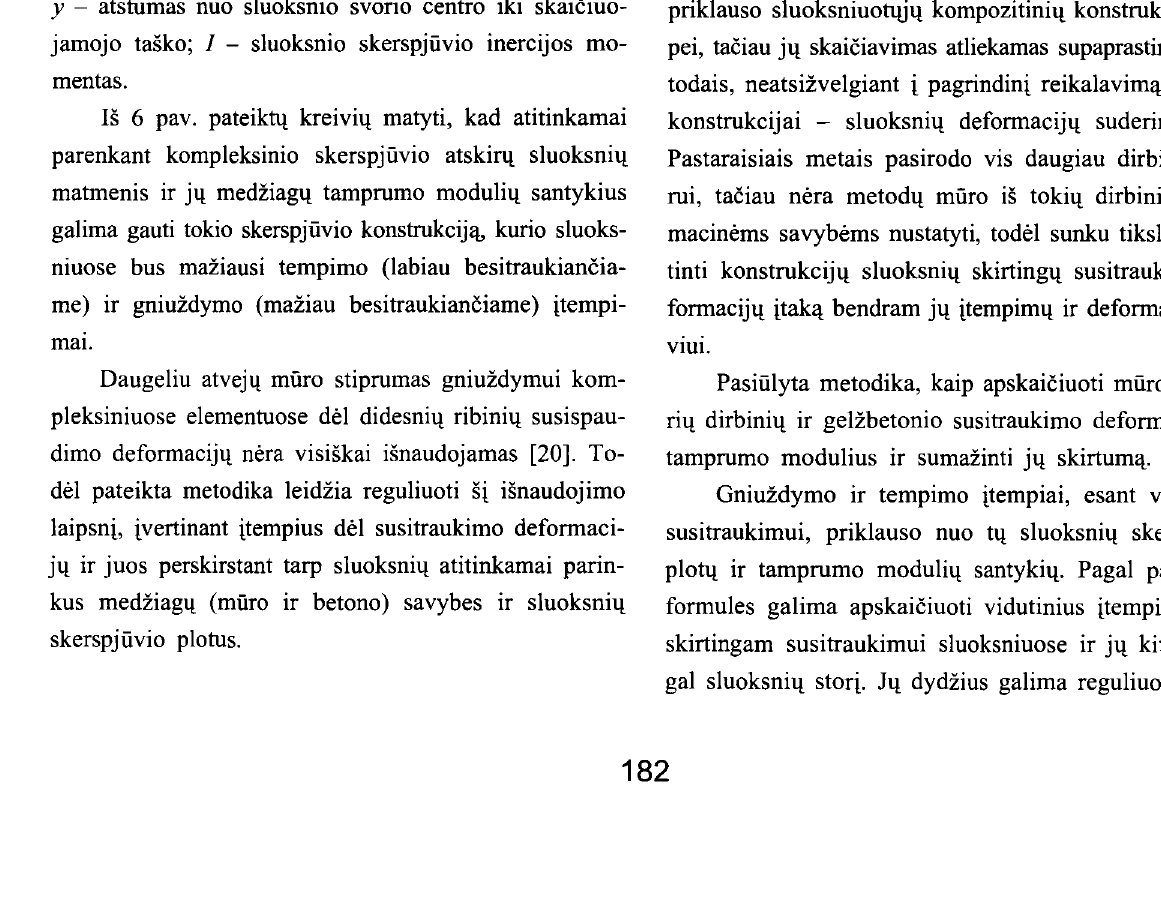
skerspjiiviq plotq (AJ! A 2 ) santykiq ir medziagq tamprumo moduliq (EI (t)j E2 (t)) santykiq: - gniuzdymo itempiai; - - - tempimo itempiai (skaiciai prie kreiviq reiSkia (EI (t)/ E2 (t)) santykiq dydi Fig 6. Average stress on dependence the ratio of cross sectional areas of the layers (A 1 / A and the modulus 2 ) ratio (£ 1 (t)/ E2 (t)): -- compression stresses, - - - tension stresses; number near lines correspond to (EI (t)/ E2 (t))